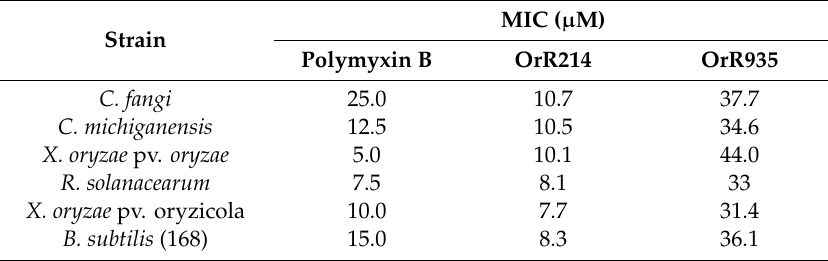
Table 1. MIC values ( µ M) of OrR214 and OrR935 peptides against various Gram-positive and Gram-negative